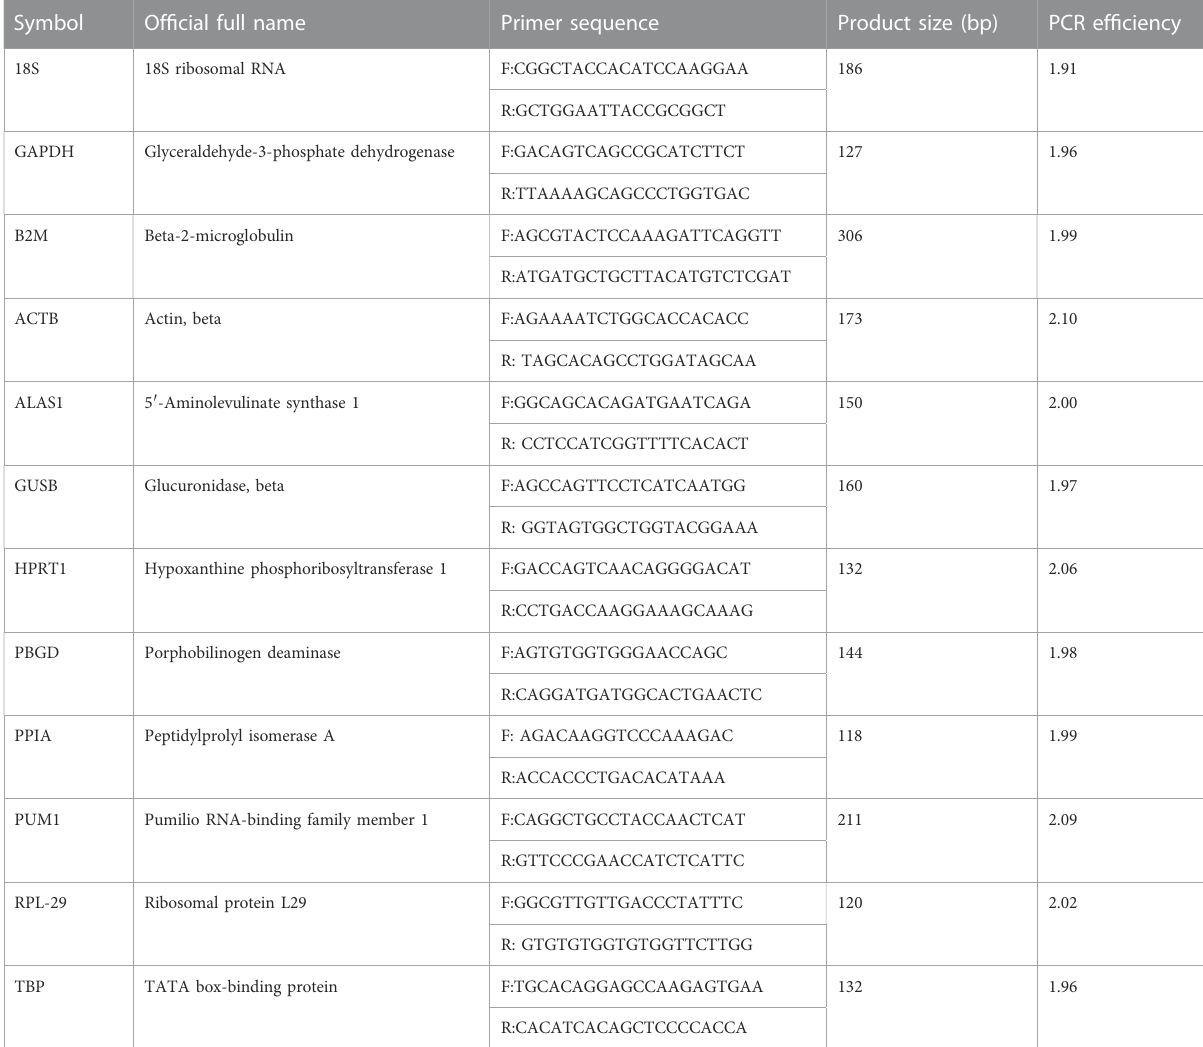
TABLE 1 Information of primer sequences for